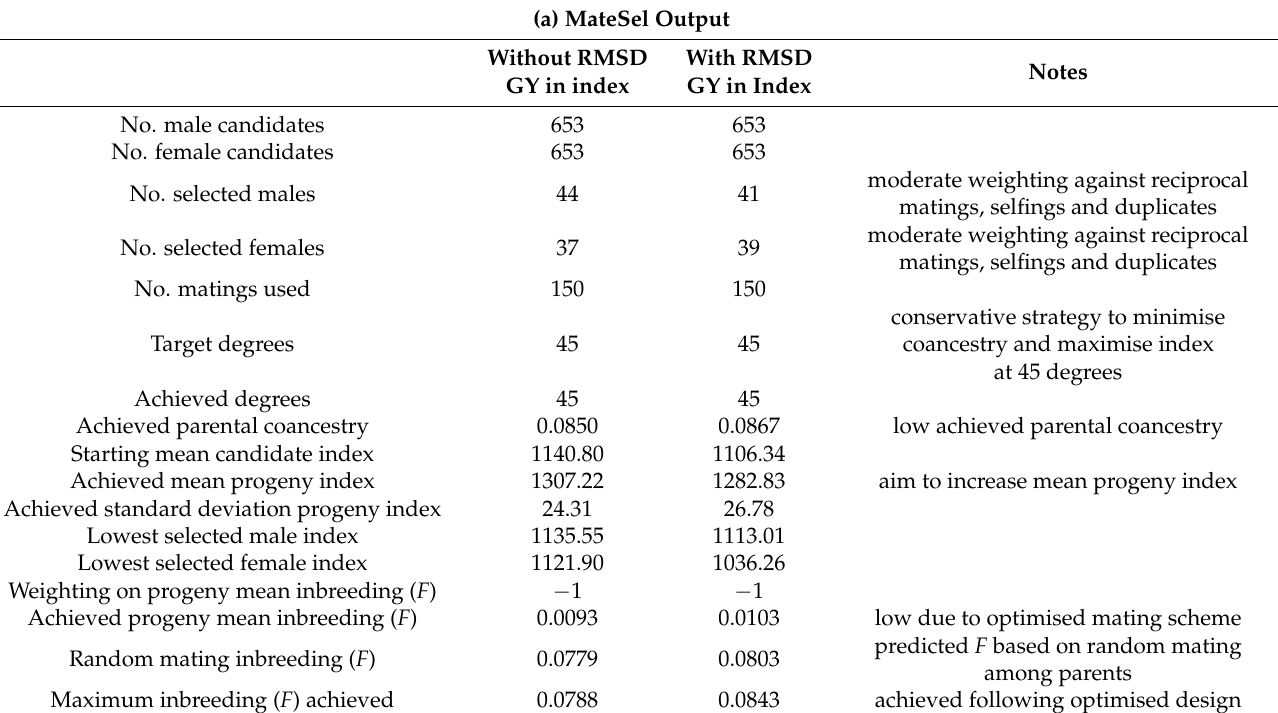
Table 5. ( a ) Output from MateSel with two optimal contribution selection (OCS) scenarios for crossing among cycle 4 parents: the economic index either includes or excludes yield stability, based on the root mean square deviation (RMSD) from the regression line associated with the first factor in the optimum MMM-FA model for grain yield (GY). The MateSel output is further explained in Kinghorn and Kinghorn (31). ( b ) Predicted response in cycle 5 with and without RMSD GY in the